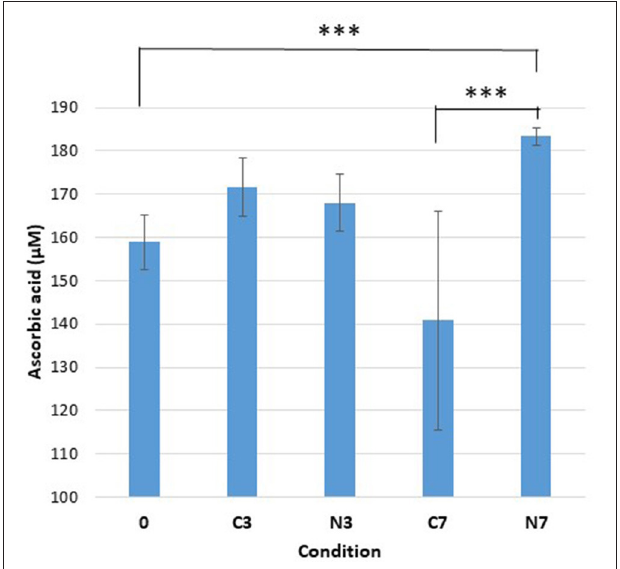
FIGURE 2 | Ascorbic acid content. Ascorbic acid concentration ( µ M) in the three raw-milk samples (M1–M3) at initial stage (0), after cold-storage for 3 and 7 days at 6 ◦ C in the controls (C3, C7), and in the cold-stored while N 2 -treated conditions (N3, N7). Each data point represents the mean value obtained from the three samples.